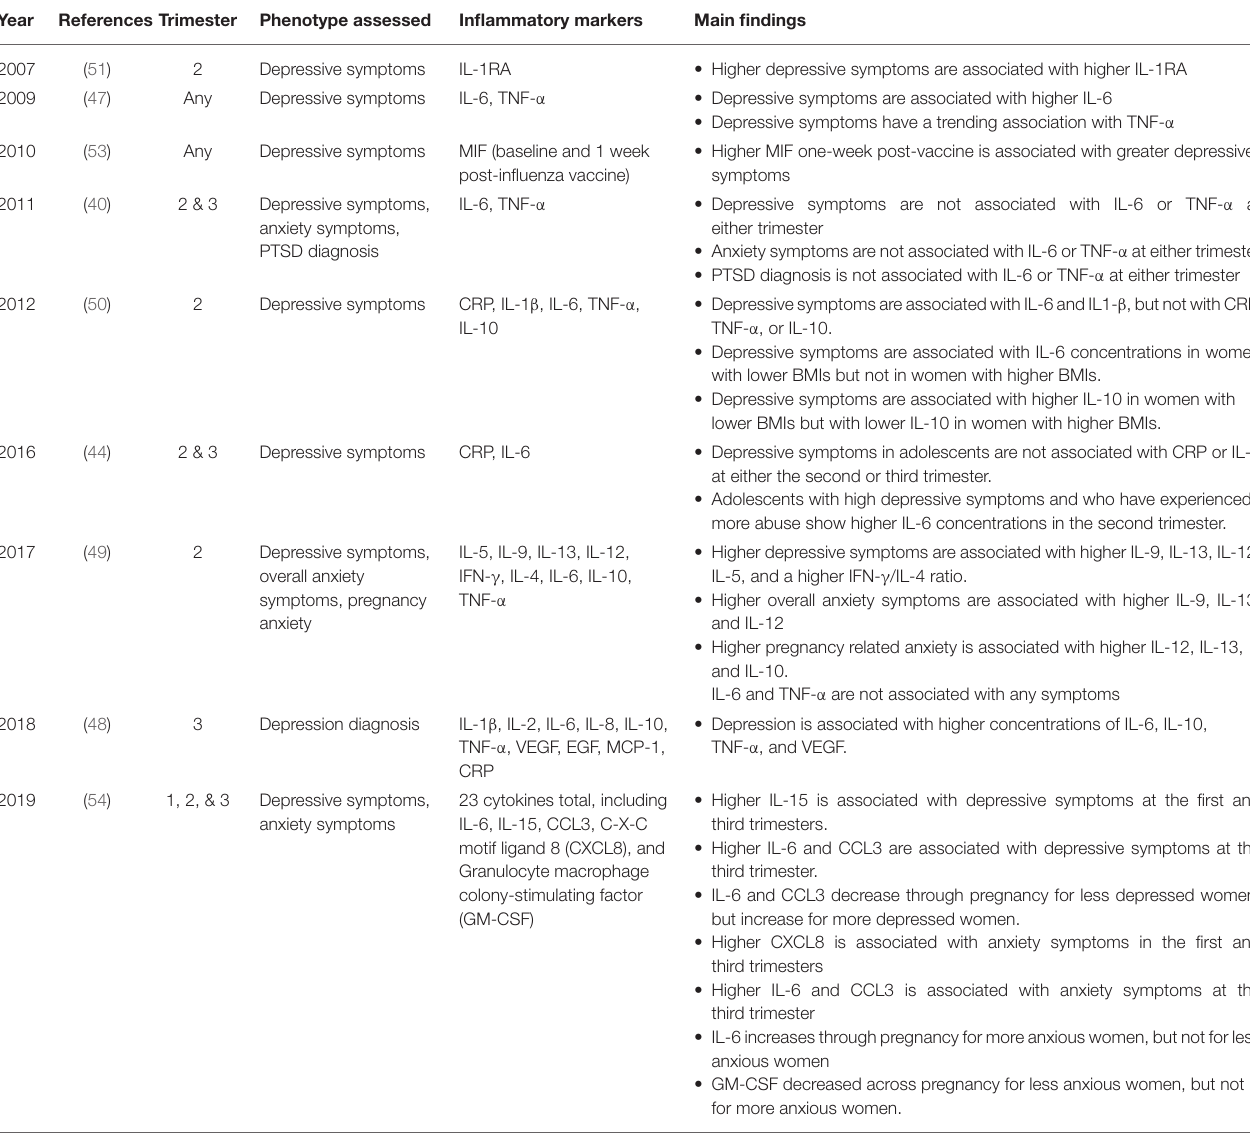
TABLE 2 | Stress-Related psychopathology and systemic inflammation in